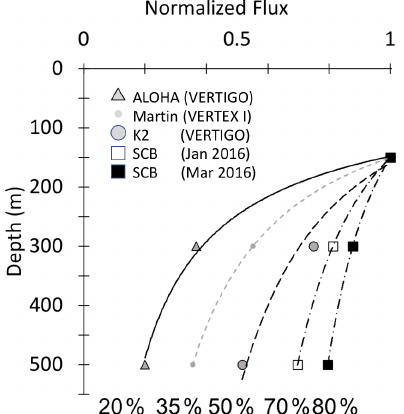
Figure 1. Martin curves normalized to 150m. Representative data from Martin et al. (1987), Buesseler et al. (2007), and Bishop et al. (2016). b values of lines from left to right are − 1 . 33 (Stn. ALOHA), − 0 . 86 (VERTEX I), − 0 . 51 (Stn. K2), − 0 . 19, and − 0 . 3 (March and January 2016, Santa Cruz Basin). Transport efficiencies between 150 and 500m range from 20% (ALOHA) to 80% (Santa Cruz